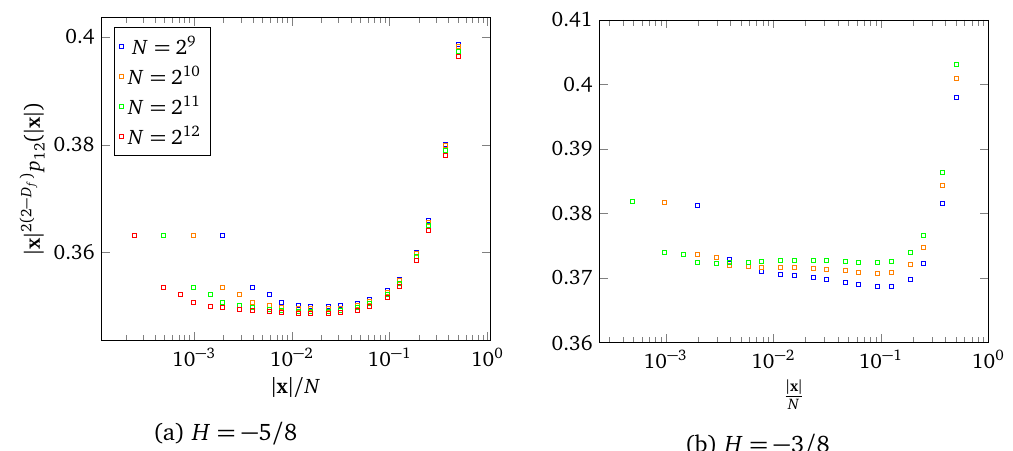
Figure 7: Convergence of the data points generated using the surface (52), on the square torus of different sizes, for H < − 5 / 8 (a) and H = − 3 / 8 (b).